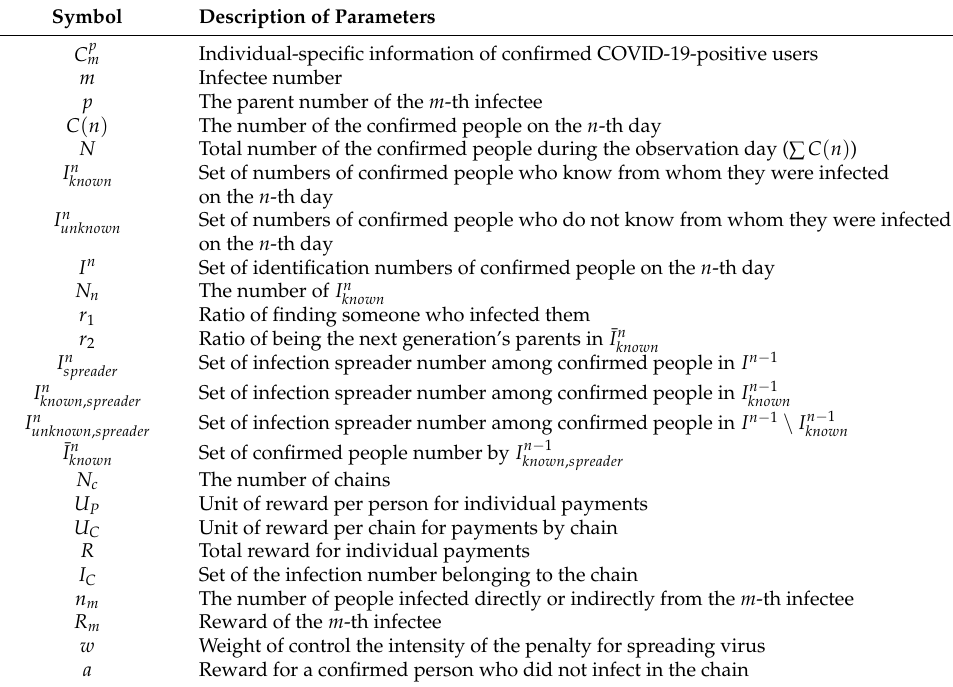
Table 1. Parameters of the proposed